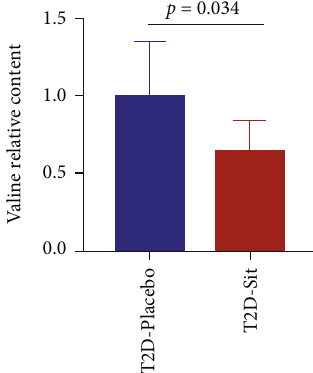
Figure 3: Sitagliptin treatment decreased valine levels in T2D patients. The relative level of valine in the T2D_Placebo and T2D_Sit groups. Data are presented as the means ± SD , t -test.